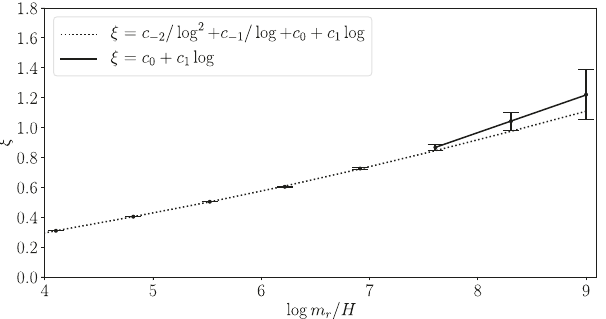
Fig. 2 Evolution of the string length. The string length per Hubble volume ξ increases with time in our simulation, indicating a logarithmic violation to the scaling solution 24 , which would predict constant ξ . At late times in the simulation (large log m r = H ) the growth in ξ appears linear in log m r = H with coef fi cient c 1 ≈ 0.25 as measured for the fi t over the full log m r = H range shown, but including terms all the way down to c (cid:3) 2 = log 2 . The fi t illustrated by the solid curve only includes terms down to c 0 but is limited to late times (log 2 ð 7 : 5 ; 9 Þ ); this fi t leads to c 1 ≈ 0.25 also. These fi ts indicate that at the beginning of the QCD phase transition, at log (cid:5) (cid:6) 65, we expect ξ * ≈ 15. The error bars in ξ correspond to normally distributed 68% con fi dence intervals derived during the fi tting procedure.